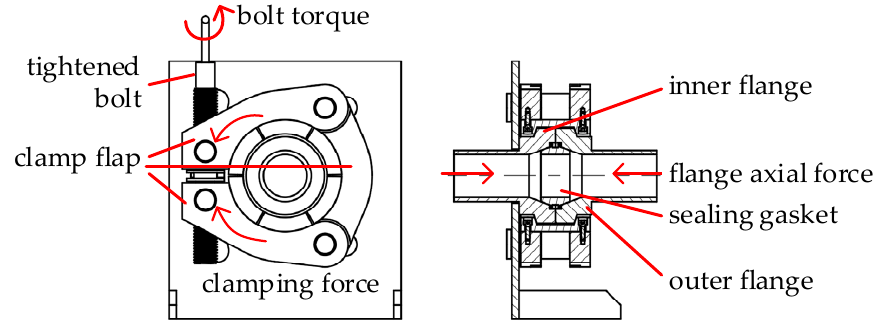
Figure 1. Mechanical transfer diagram of clamp connector.